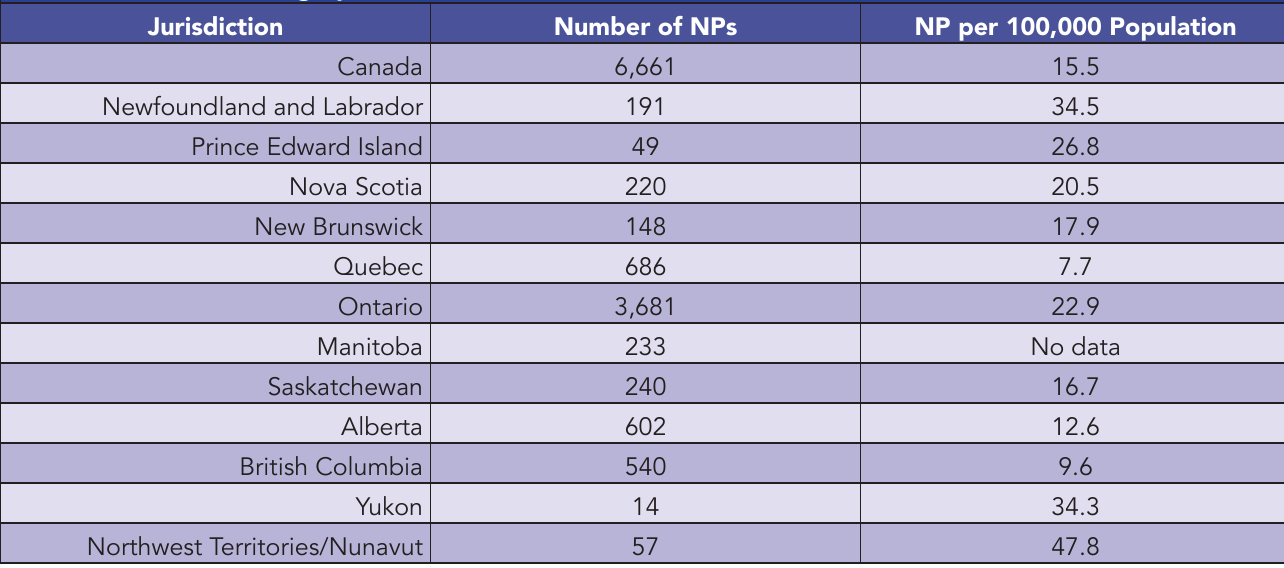
Table 2. The geographic distribution of the NP workforce in 2020 Geographic Distribution of the NP Workforce in 2020 (CIHI, 2021b